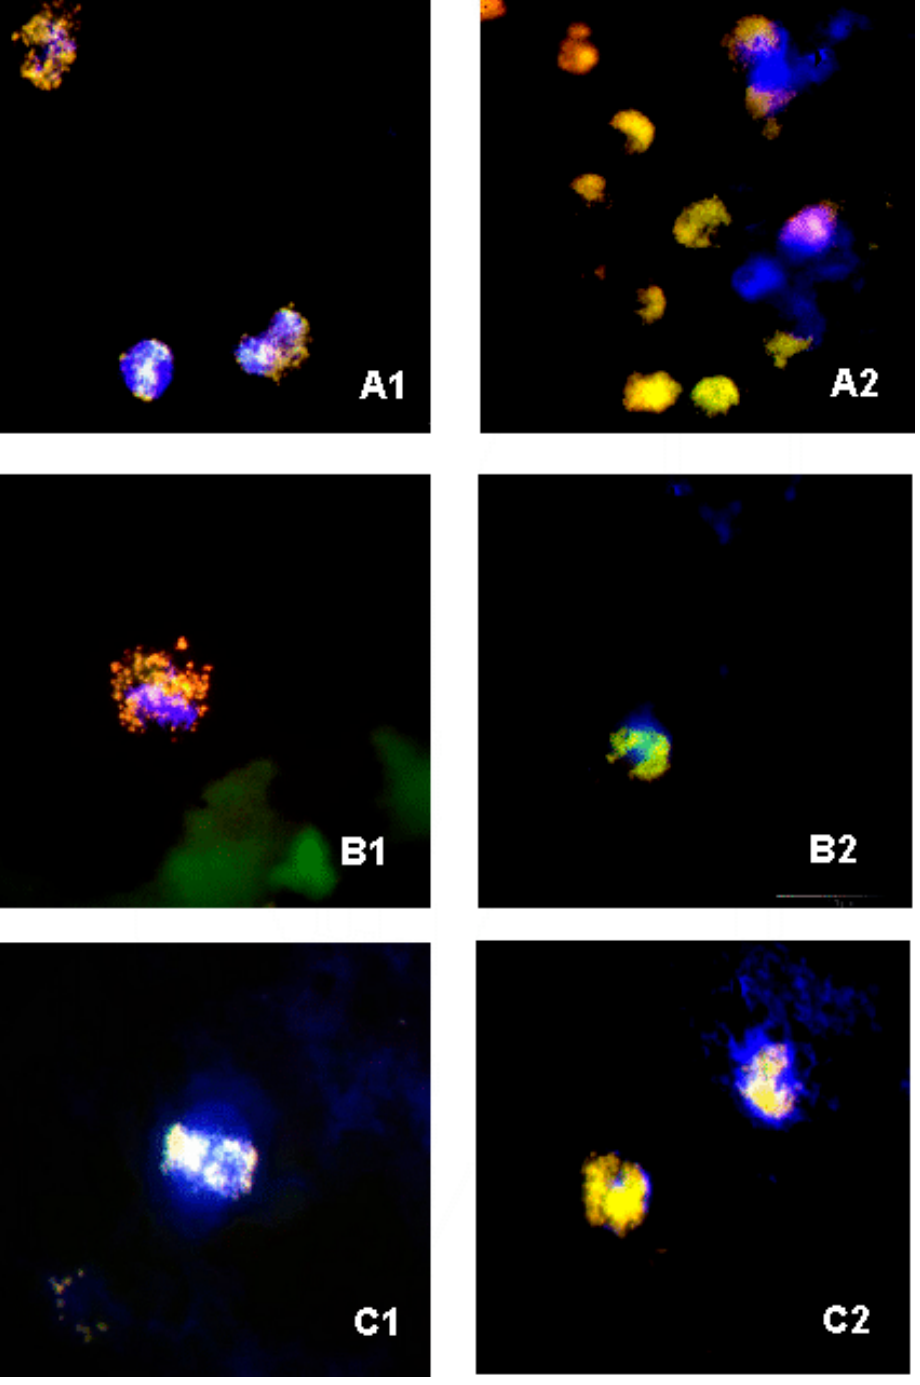
Figure 4. FISH photos from a fluorescent microscope: ( A1 , A2 ) blood sample from septic patients—smear with probes STA and EUB338—visible phagocytosed Staphylococcus spp. cells; ( B1 , B2 ) negative samples in blood culture media—smear with probes STA, ENT183 and EUB338—visible phagocytosed Staphylococcus spp. and Enterobacteriaceae cells; ( C1 , C2 ) blood sample from healthy volunteers—smear with probes STA, ENT183 and EUB338— visible phagocytosed Staphylococcus spp. and Enterobacteriaceae cells. 1000x